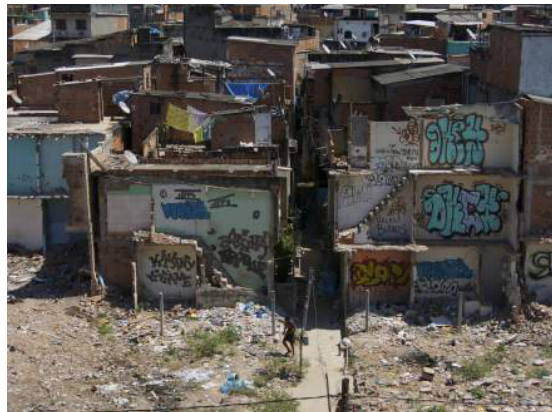
Figure 3. Partially demolished housing, Manguinhos favela,